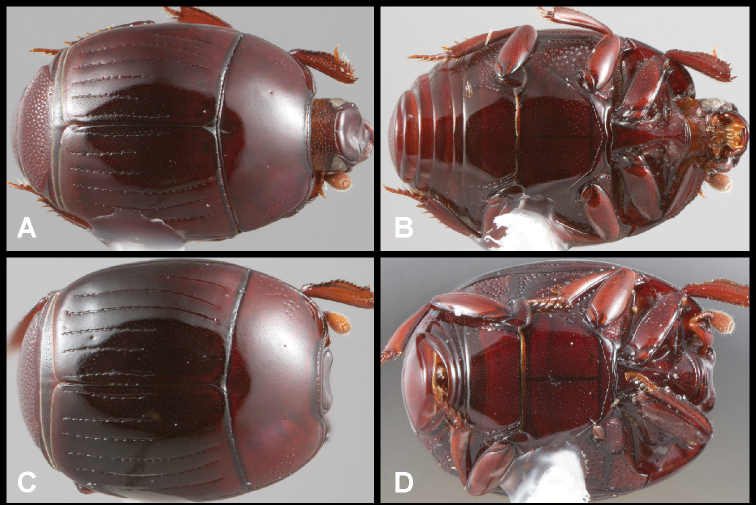
A, BPhelister
microdens: A dorsal habitus B ventral habitus C, DP.
matatlantica: C dorsal habitus D ventral habitus.